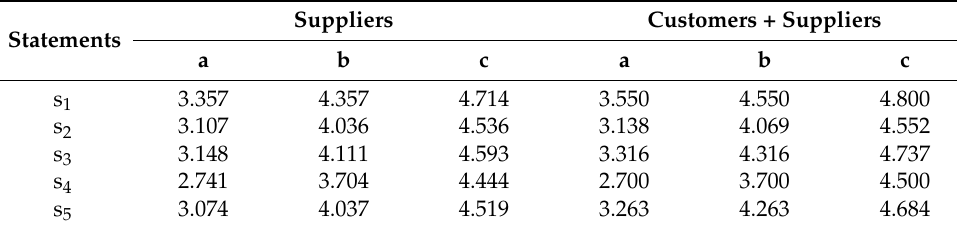
Table 4. Average ratings of the statements presented by the enterprise representatives in the form of triangular fuzzy numbers (a group of suppliers vs. a group of customers and suppliers